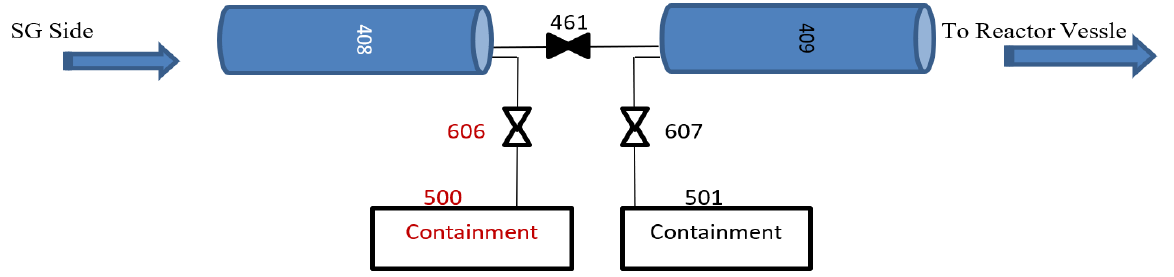
Figure 3. DELOCA (Guillotine Break) nodding diagram.